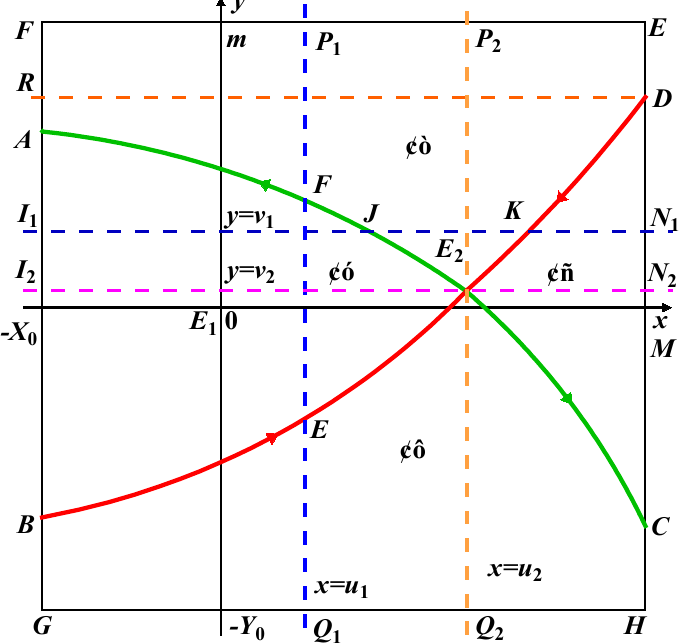
Figure 4. Qualitative analysis of nonlinear dynamic evolution trend on the human–machine safety . When line x = u 1 moves to the right, the safety oscillation area will decrease, while the safety enhancement area and the safety deterioration area will increase. When line x = u 1 moves to the left, the safety oscillation area will increase, while the safety enhancement area and the safety deterioration area will decrease. Given that the line x = u 2 is of one